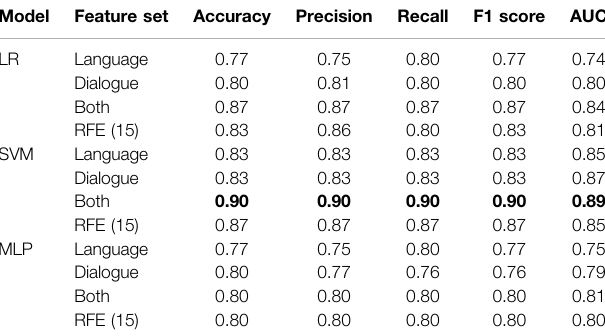
TABLE7| ComparisonofresultsfortheADclassi fi cationwiththreeclassi fi erswith LOOCV. Model Feature set Accuracy Precision Recall F1 score AUC LR